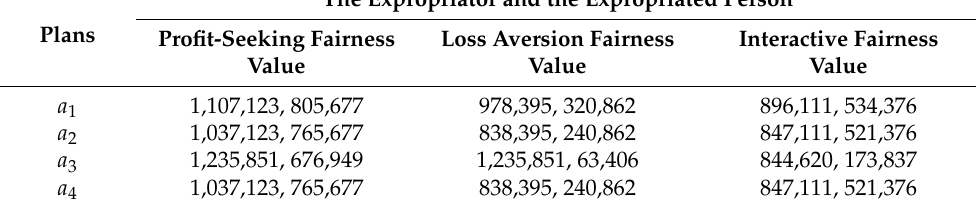
Table 11. Multidimensional fairness game matrix of expropriation compensation to the east of the Friendship Store.